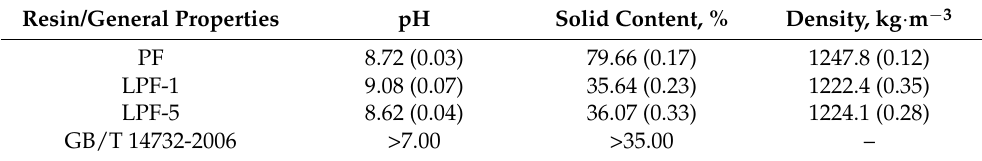
Table 3. General properties of resins at T = 21 ◦